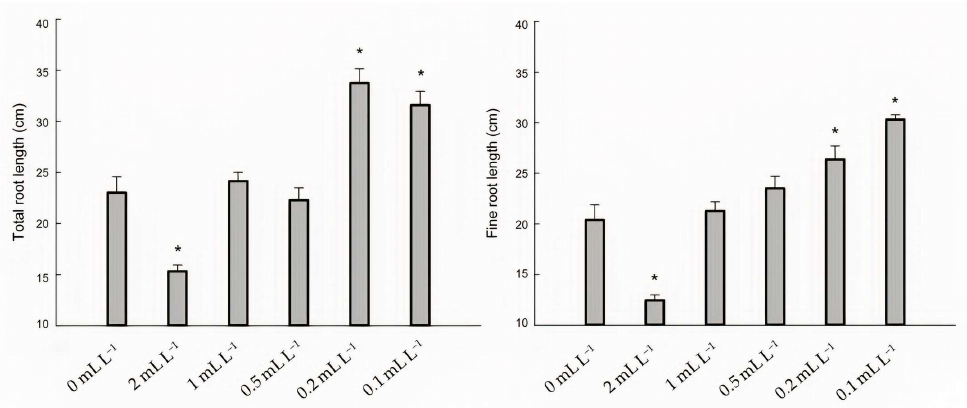
Figure 4. Total root length (cm) and fine root length (cm) of seedlings grown in hydroponics 48 h after treatment. “*” identifies the group of treated plants whose means are significantly different from the untreated (0 mL L −1 ) at p < 0.05, after Duncan’s post hoc test.